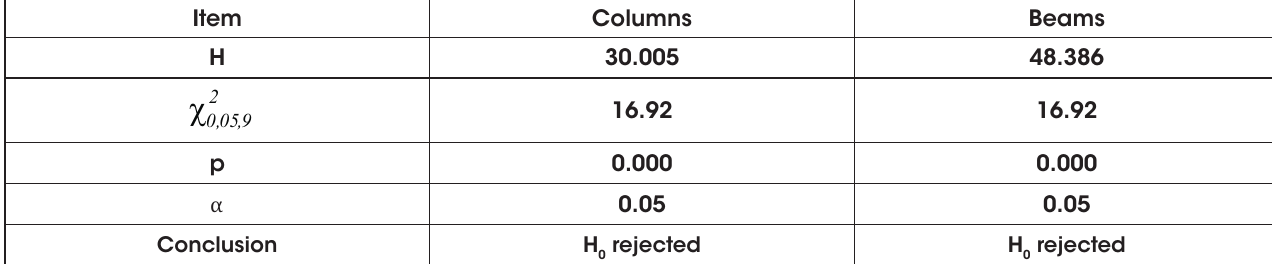
Results of Kruskal-Wallis test for columns and beams (verifying differences per buildings)